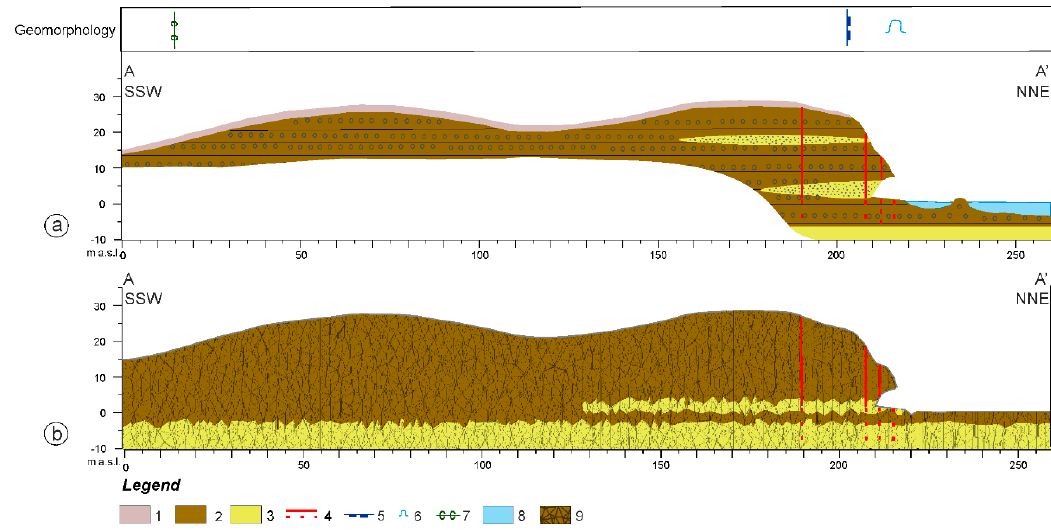
Figure 4. ( a ) Geological–geomorphological section and ( b ) interpolated-simplified section for the numerical modelling. Legend: 1. Colluvial, eluvial deposits; 2. Conglomerate; 3. Sandstone; 4. Joint (discontinuous line = probable prosecution); 4. Active cliff; 5. Sea cave; 6. U-shaped valley; 7. Sea; and 8. FLAC3D mesh. Table 1. Physical mechanical parameters of the lithotypes. Legend: γ volume weight (kg/m 3 ); φ ’ internal friction angle (°); c’ apparent cohesion (Pa); K bulk modulus (Pa); G shear modulus (Pa); and Ϭ tmax tension strength (c’/ tan φ ') (Pa). Lithotype Conglomerate Sandstone Sand Clay